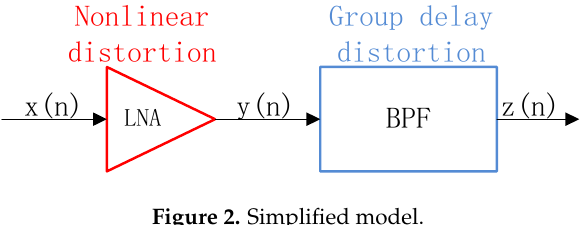
Figure 2. Simplified model.